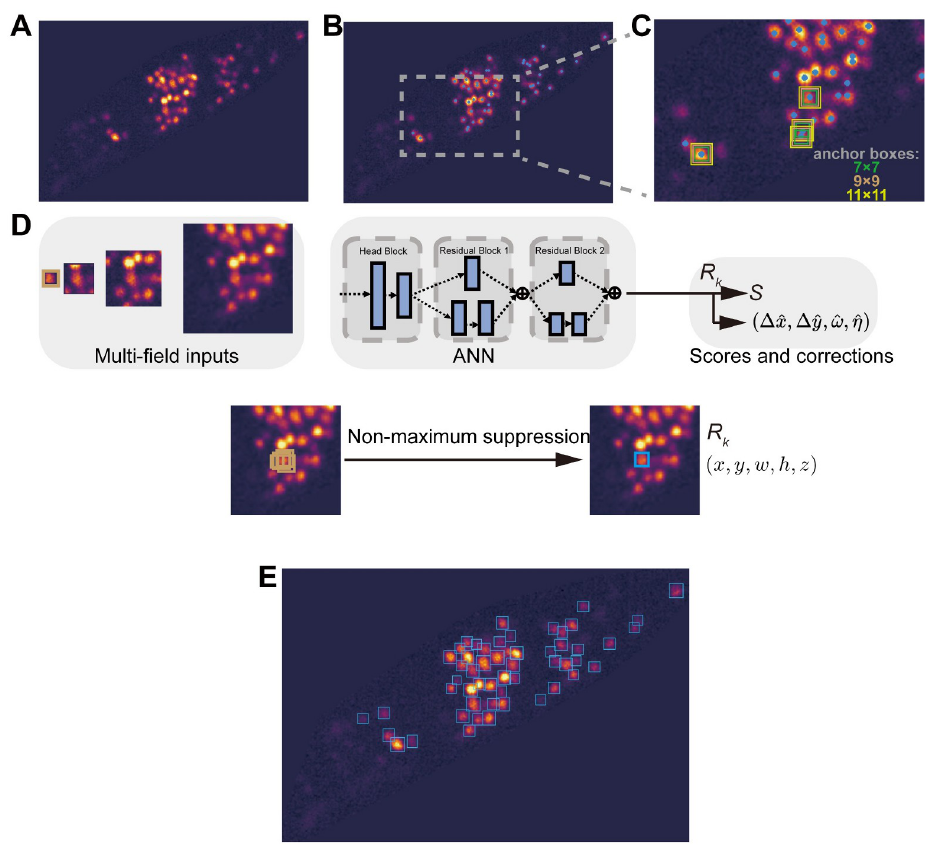
Fig 3. Multi-Field Detection (MFD). (A) A cropped head region. Every frame in a volume is cropped in the same way. (B) Find local pixel intensity maxima (blue points) in A . (C) An enlarged view of the rectangular region in B . Anchor boxes of different sizes are centered at 3 local maxima. The green, brown or yellow rectangle represents a 7 × 7, 9 × 9 or 11 × 11 anchor box, respectively. (D) Up: an artificial neural network (ANN) including residual blocks receives multi-field inputs once at a time and outputs a score S and corrections ð D ^ x ; D ^ y ; ^ o ; ^ Z Þ to the position and shape of an input anchor box. Bottom: ANN outputs several candidate bounding boxes surrounding an input local maxima, from which the optimal one is chosen by the non-maximum suppression algorithm. (E) A detection result (also see S3 Fig). Refined anchor boxes centered at local pixel intensity maxima are filtered by a non-maximum suppression algorithm. Blue rectangles are detected neuronal